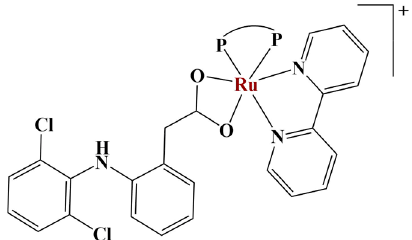
Figure 17. The complexes presented in